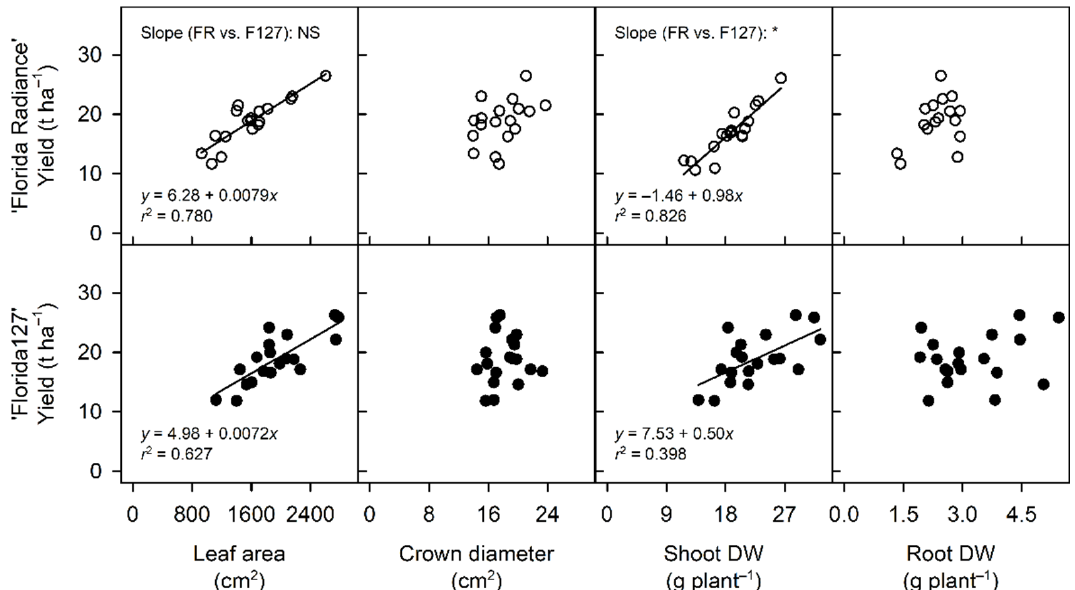
Figure 3. Linear regression between mid-season growth variables and the total season yield in two strawberry cultivars in the 2014–2015 growing season. Treatments are as described in Table 2. Plant growth data were collected on 13 January 2015. No regression line is shown when the correlation was non-significant ( p > 0.05). When the linear correlation was significant for both cultivars, the slopes were compared between the two linear models using 95% confidence intervals. DW = dry weight. FR = Florida Radiance. F127 = Florida127. NS = non-significant. * = significant ( p ≤ 0.05).